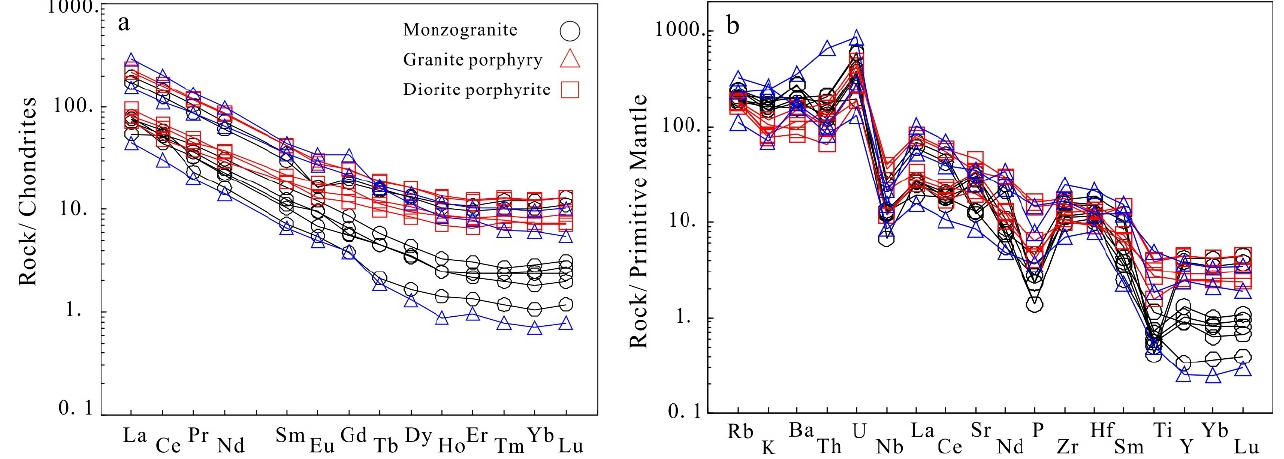
Figure 6. ( a ) Chondrite-normalized REE patterns; and ( b ) primitive mantle-normalized multi-element diagrams for the monzogranite, granite porphyry, and diorite porphyrite.